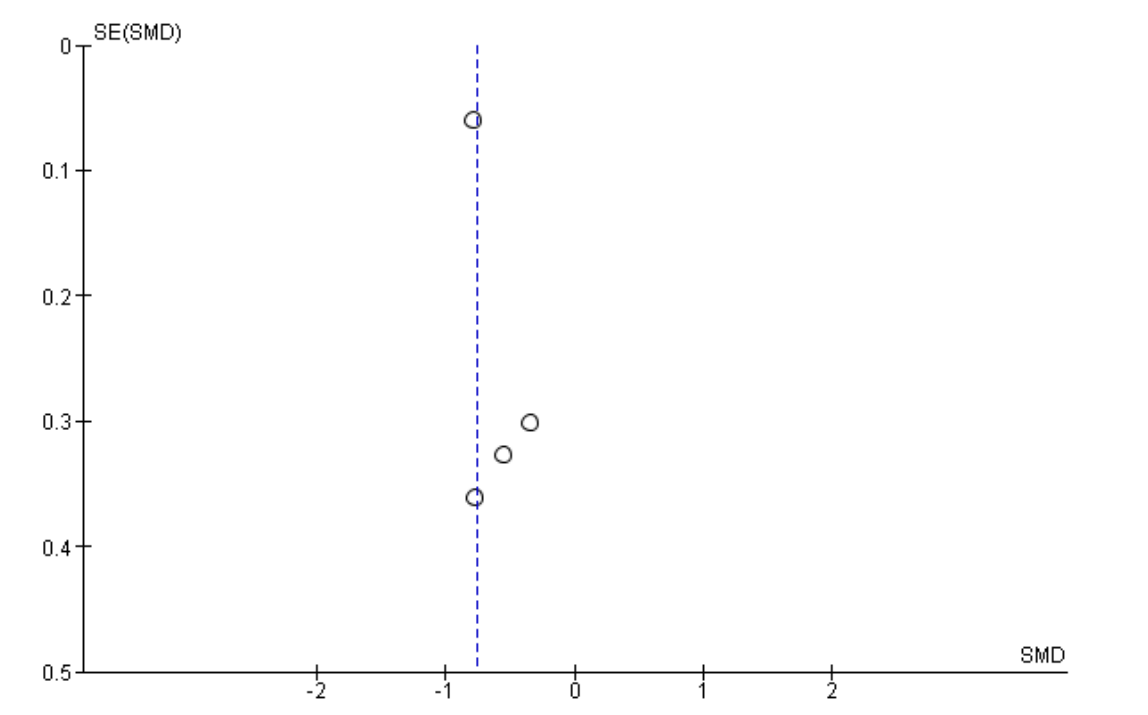
Figure 9. Anxiety nature walk vs. control funnel plot.